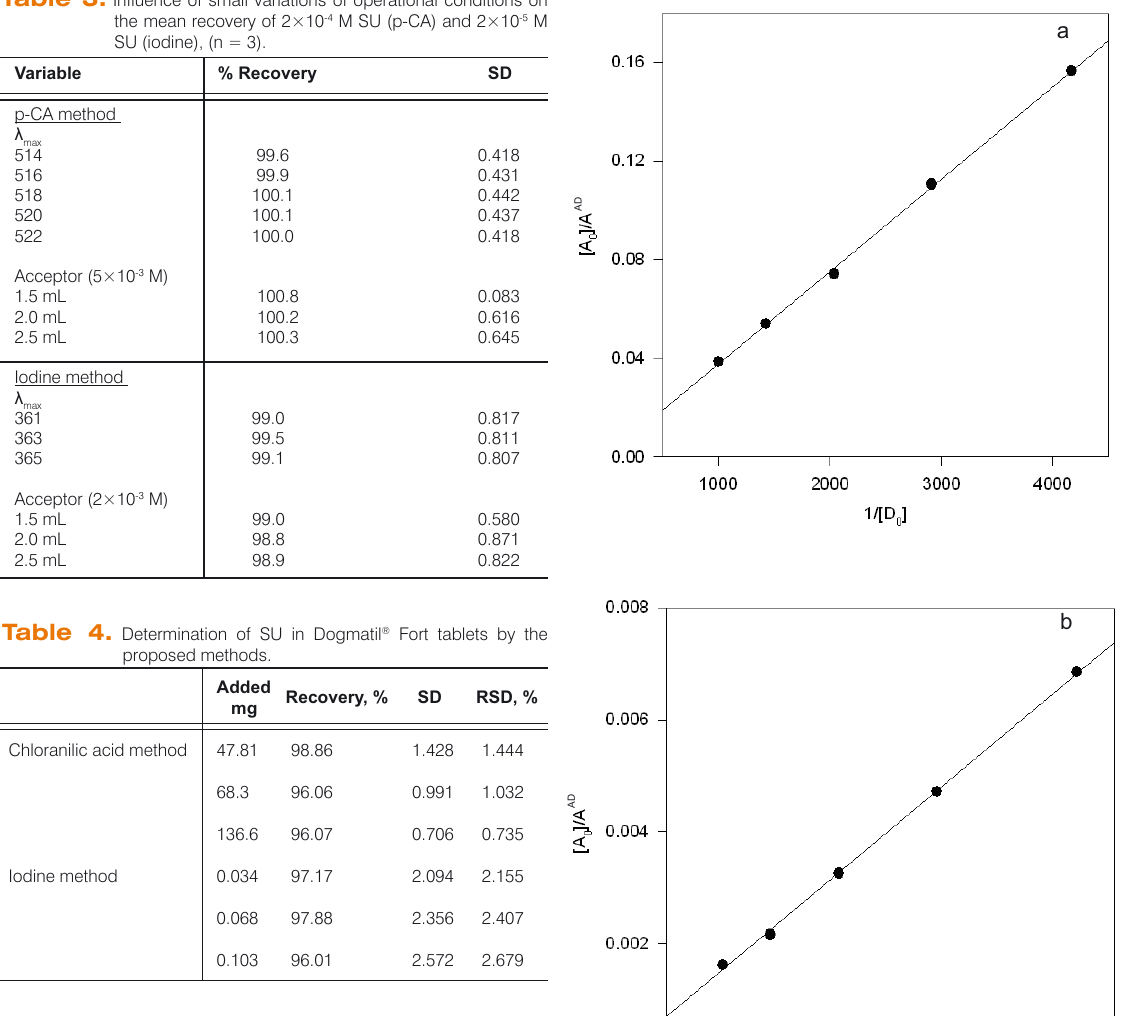
Table 5. Statistical comparison between results of Dogmatil ® Fort tablets by the proposed and official methods. Parameter